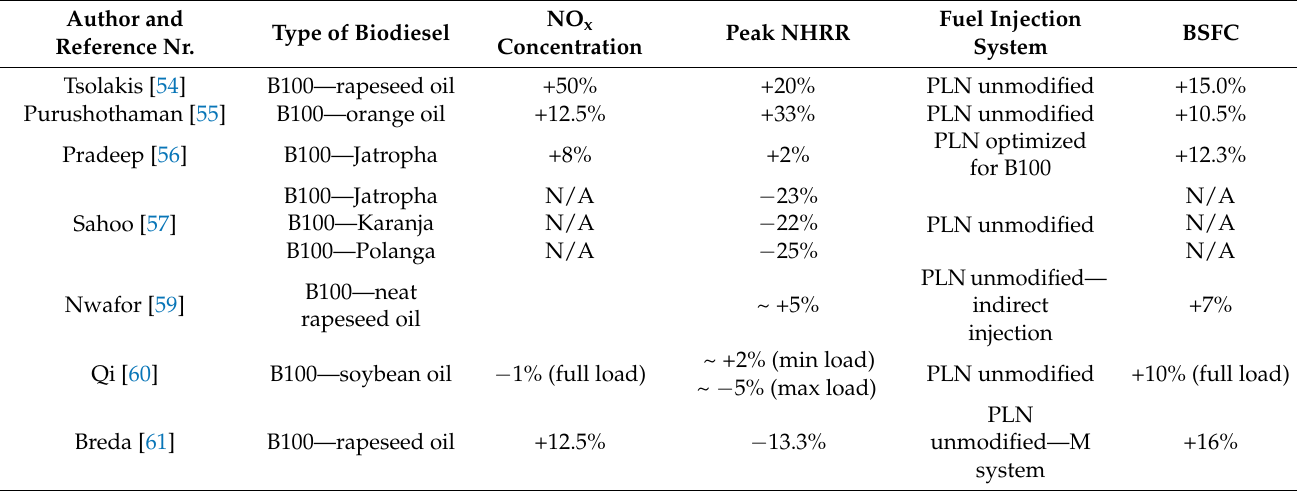
Table 4. Main characteristics, emissions, and performance of biodiesel-fueled engines in the presented